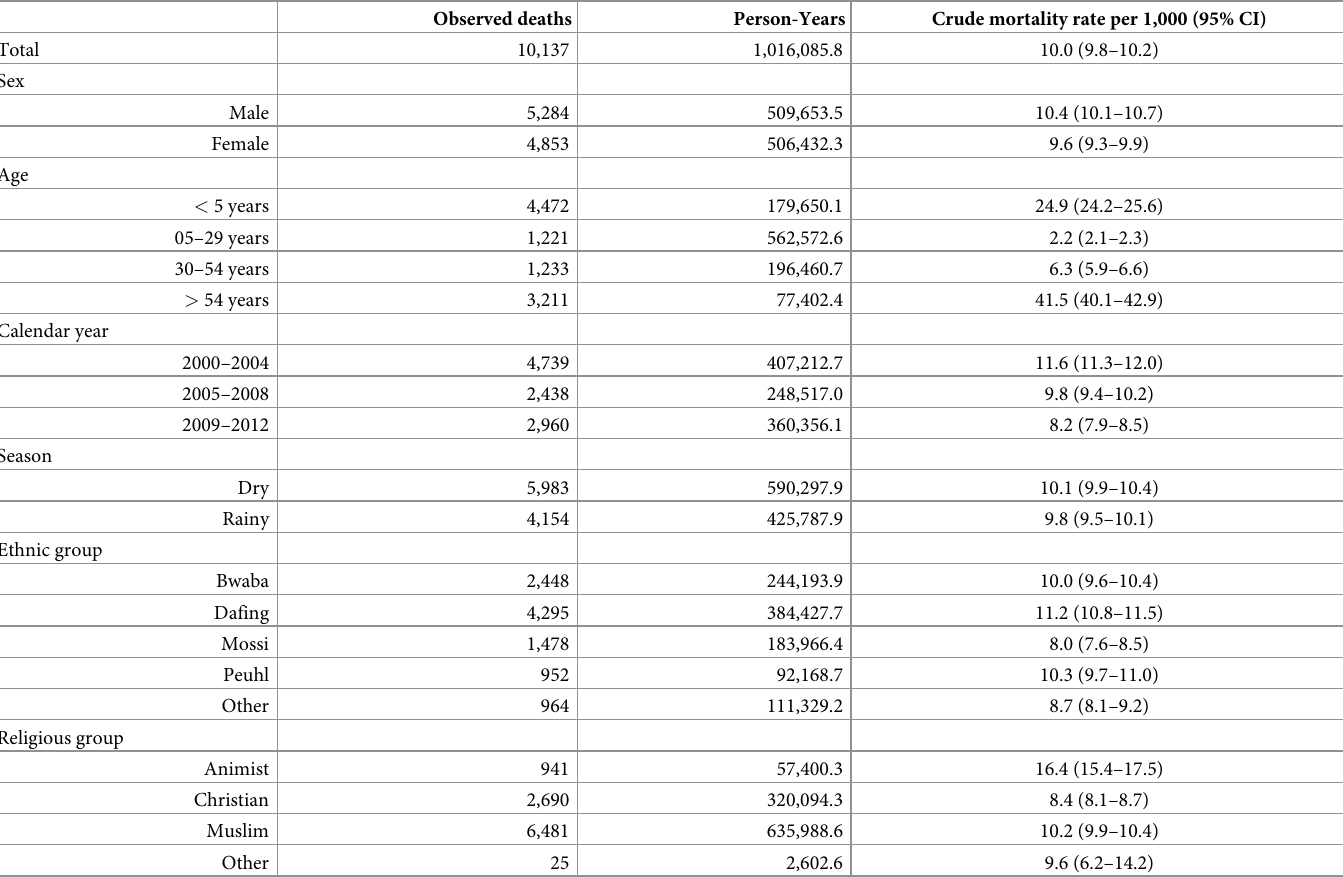
Table 1. Sample characteristics of the Nouna Health and Demographic Surveillance System from